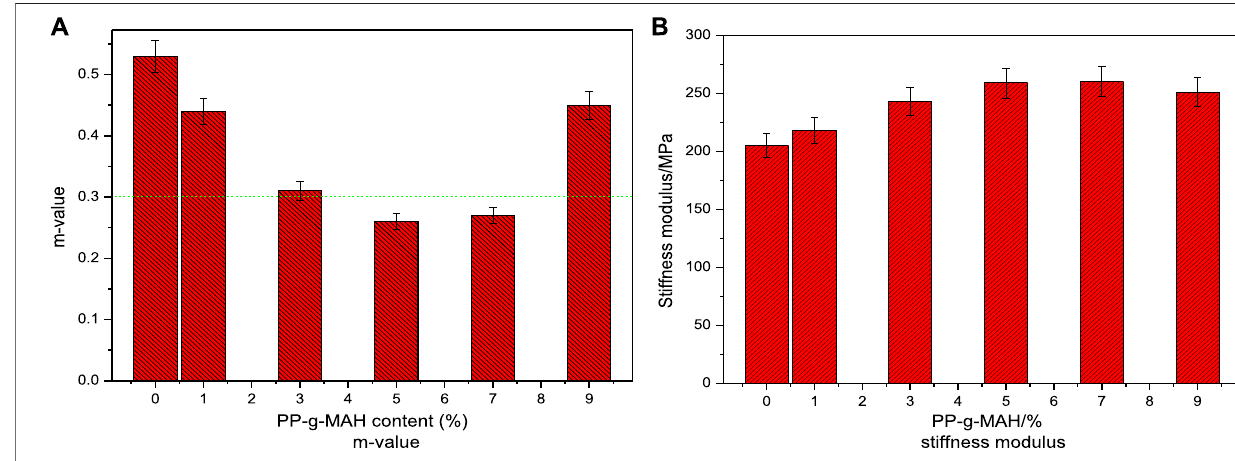
FIGURE 13 | m-value and stiffness S of asphalt modi fi ed with different PP-g-MAH content.